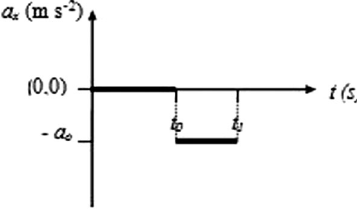
FIG. 27. Force-position graph requesting qualitative